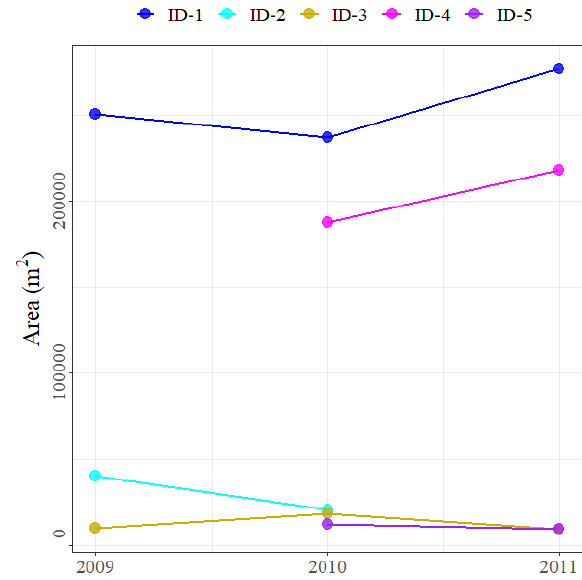
Figure 4. Changes in mapped area for each landslide-dammed lake during three successive years, 2009, 2010, and 2011. The IDs (1 to 5) are the same as the IDs in Table